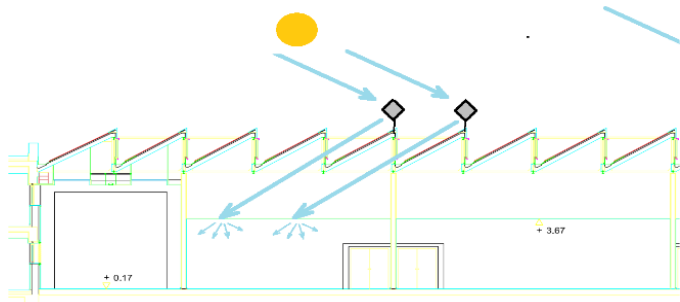
Figure 4. Diagram of installation of heliostatic illuminators on the roof of the Leonardo da Vinci building of the Rabanales University Campus of the University of Córdoba (Spain).